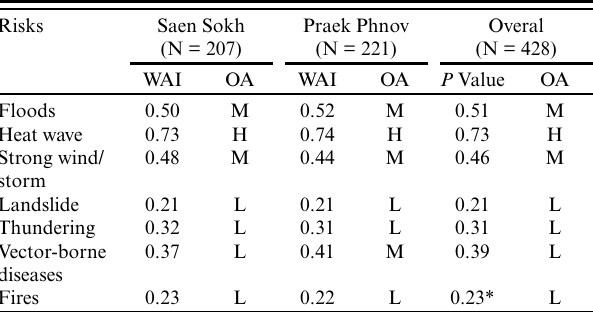
Table 2 . Perceptions on the level of climate-related risks affecting urban